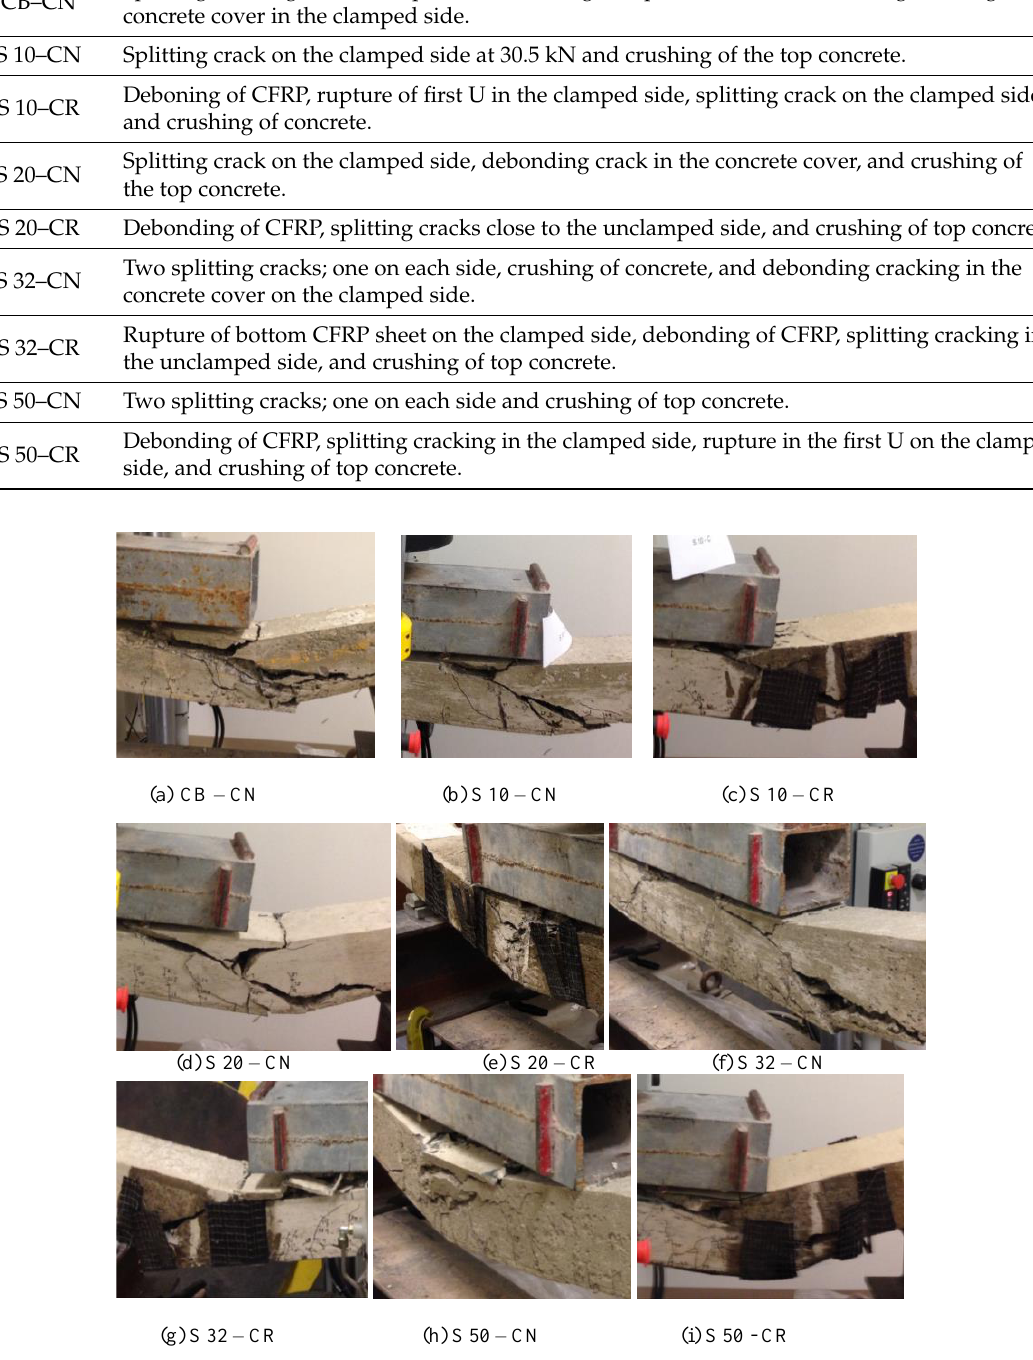
Figure 7. Failure of control beam and beams with simulated corrosion.